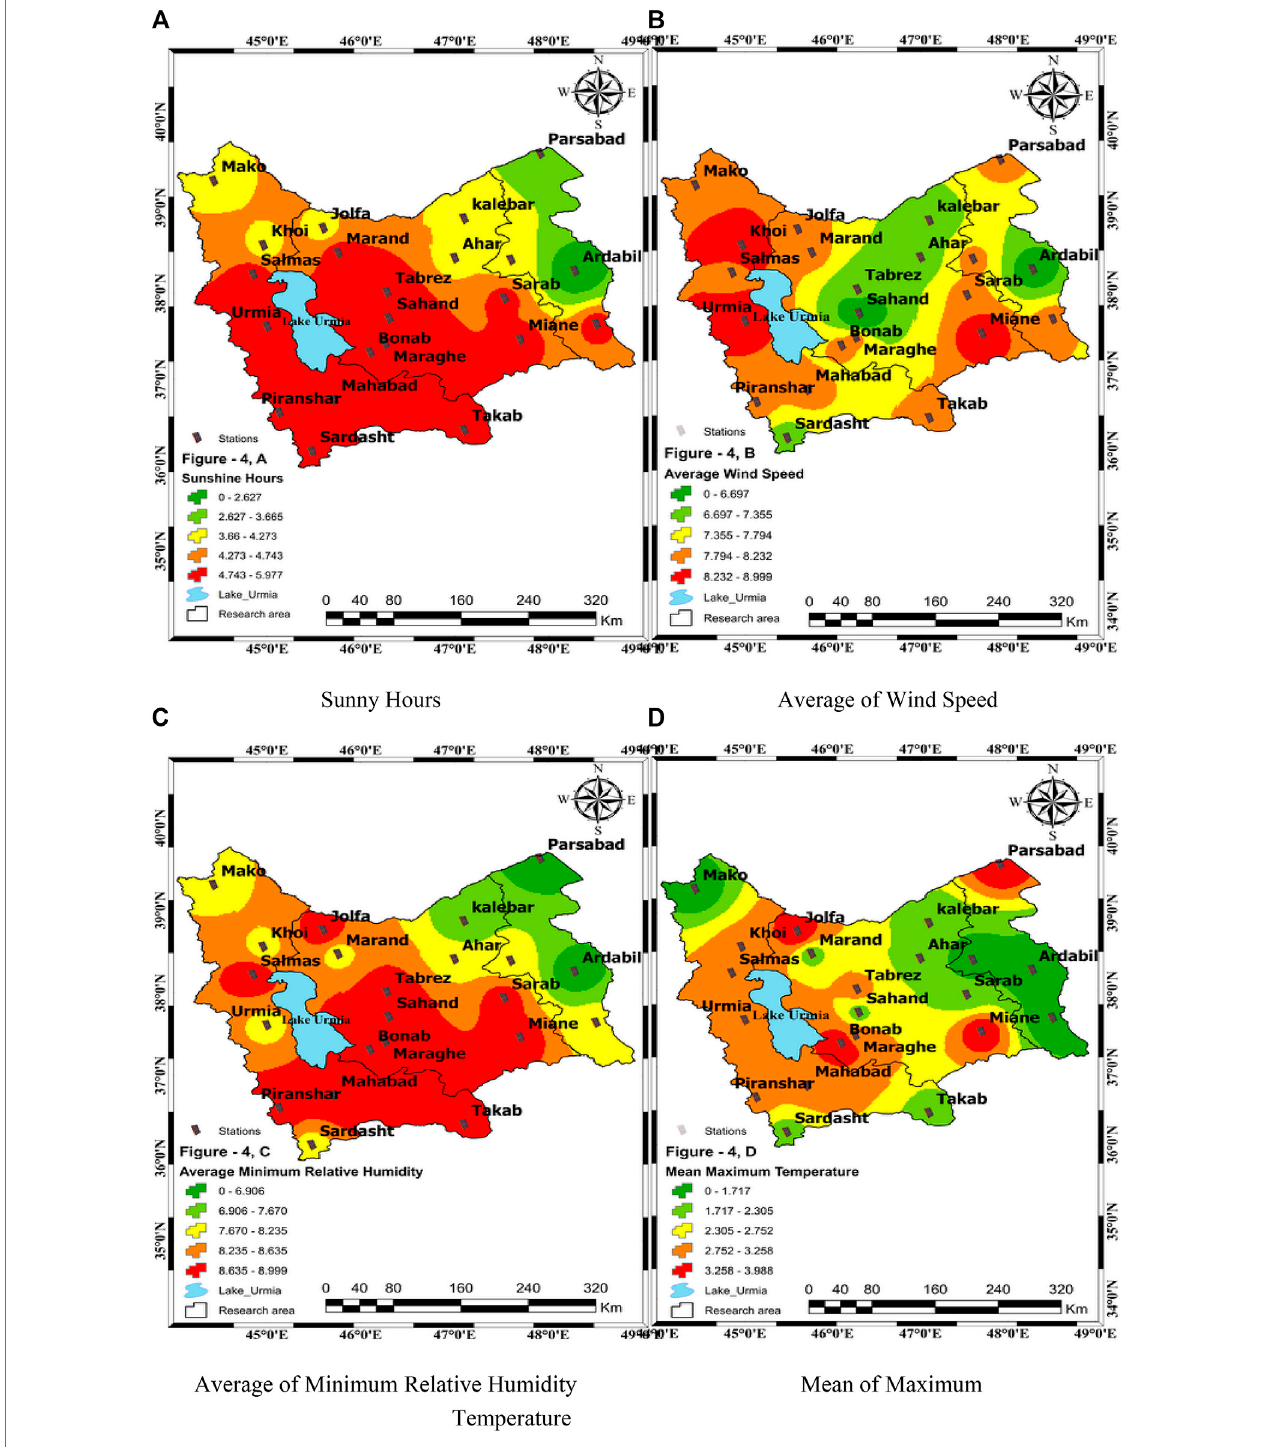
FIGURE4| Thezoningoftheparameters affecting theestablishment ofthermalsolarpower plant,Source: Authors. (A) SunnyHours. (B) AverageofWindSpeed. (C) Average ofMinimum Relative Humidity. (D) Mean ofMaximum Temperature. (E) Mean Temperature. (F) Means ofRelative Humidity. (G) Total Monthly Precipitation. (H)